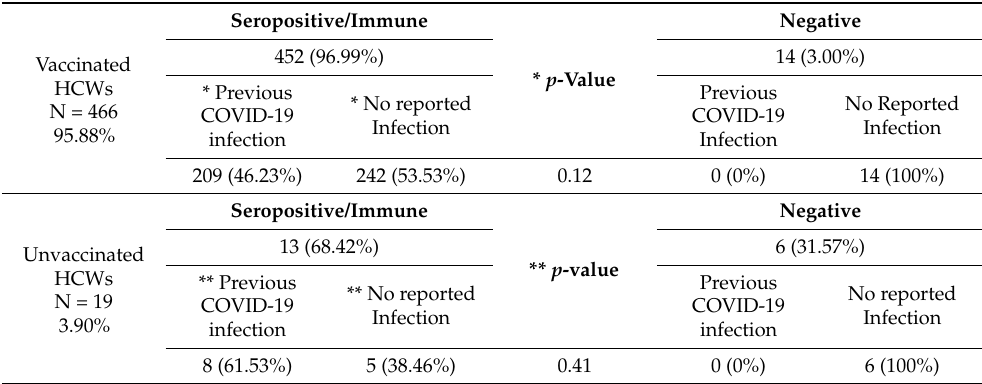
Table 3. COVID-19 infection rate before sample testing among vaccinated and non-vaccinated HCWs and their seroconversion status.